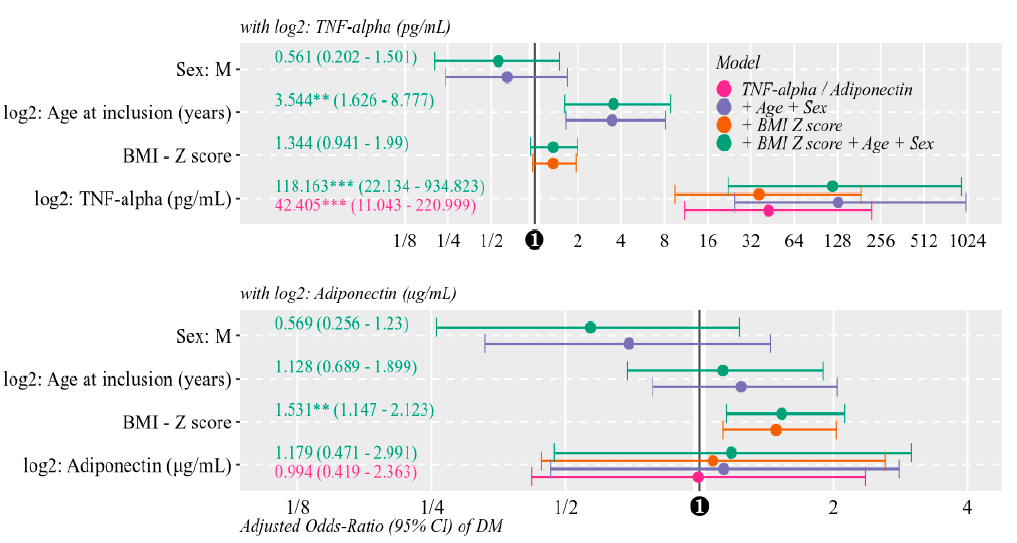
Figure 4. Logistic models for odds-ratios of T1DM by adiponectin or TNF- α , unadjusted (purple) and adjusted for BMI Z score (orange), age at inclusion and gender (blue), and all three covariates combined (green). Adiponectin, TNF- α and age were transformed to base 2 logarithms, therefore odds ratios are referenced to every doubling of original values. ( p -value = ⁺ : <0.10, **: < 0.01, ***: <0.001).